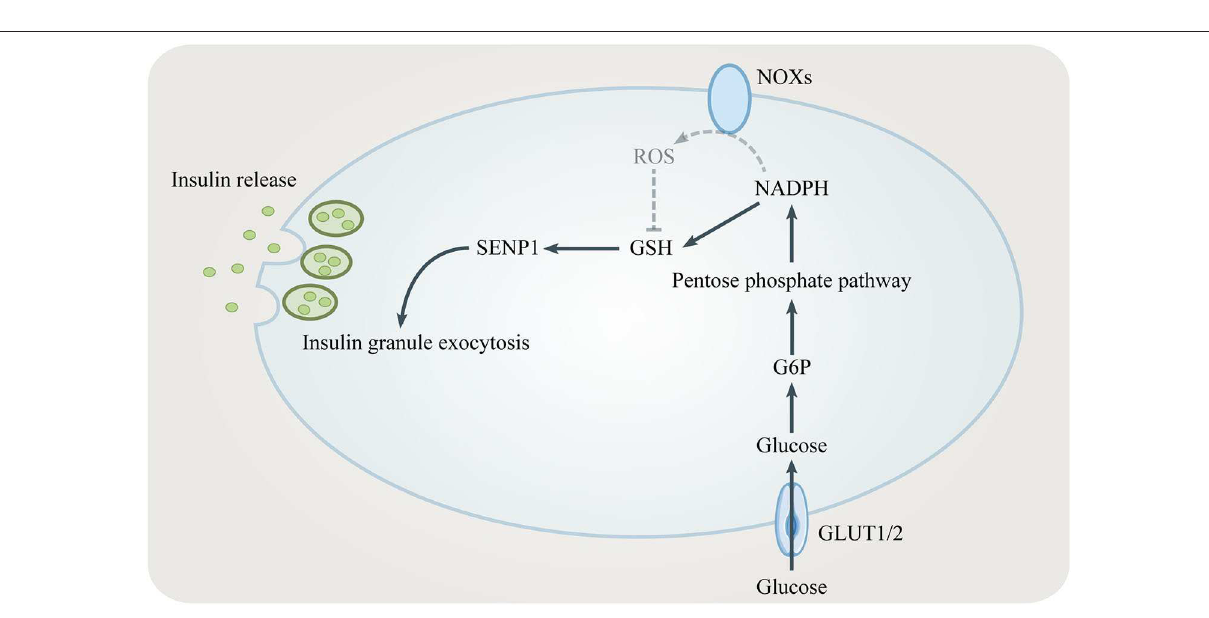
FIGURE 3 | The role of the PPP in insulin secretion. NADPH from the PPP converts oxidized glutathione (GSSG) to reduced glutathione (GSH). GSH elicits insulin granule exocytosis via SENP1. However, NADPH might inhibit insulin secretion by promoting NADPH oxidases